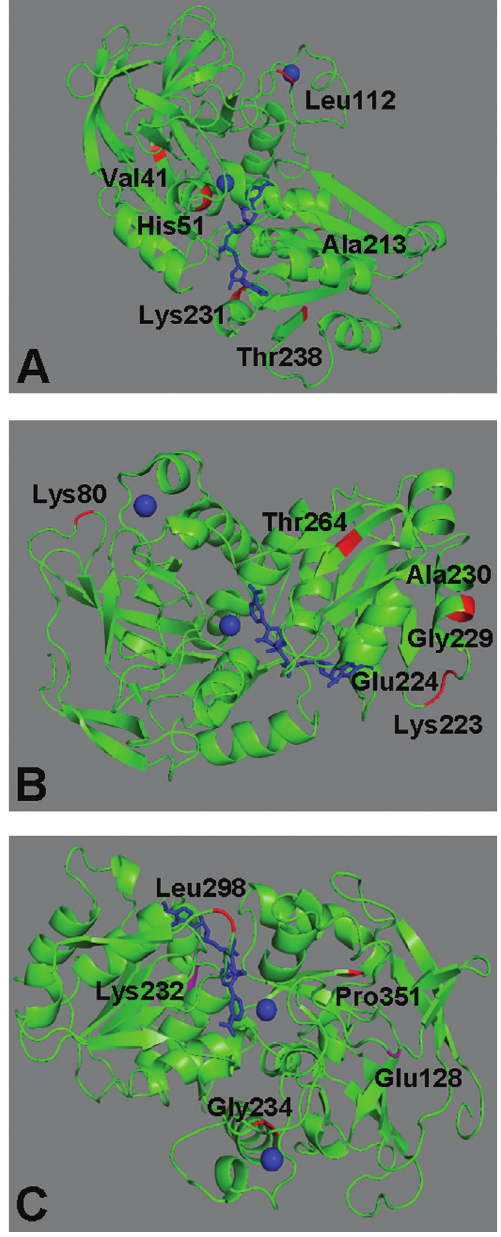
Figure 4 - Three-dimensional structures of alcohol dehydrogenase from: A. Homo sapiens (ADH1, PDB ID 1HDX, chain A), B. Saccharomyces cerevisiae (ADH1, PDB ID 4W6Z, chain A), and C. Gadus morhua (ADH1, PDB ID 1CDO chain A). Blue spheres = zinc ions. Blue bars = nicotinamide-adenine dinucleotide (NAD) in A and C, and nicotinamide- 8-iodo-adeninedinucleotide(8ID)inB.Aminoacidsresponsibleforfunc- tionaldivergenceandtheirrespectivepositioninthePDBsareindicatedin the